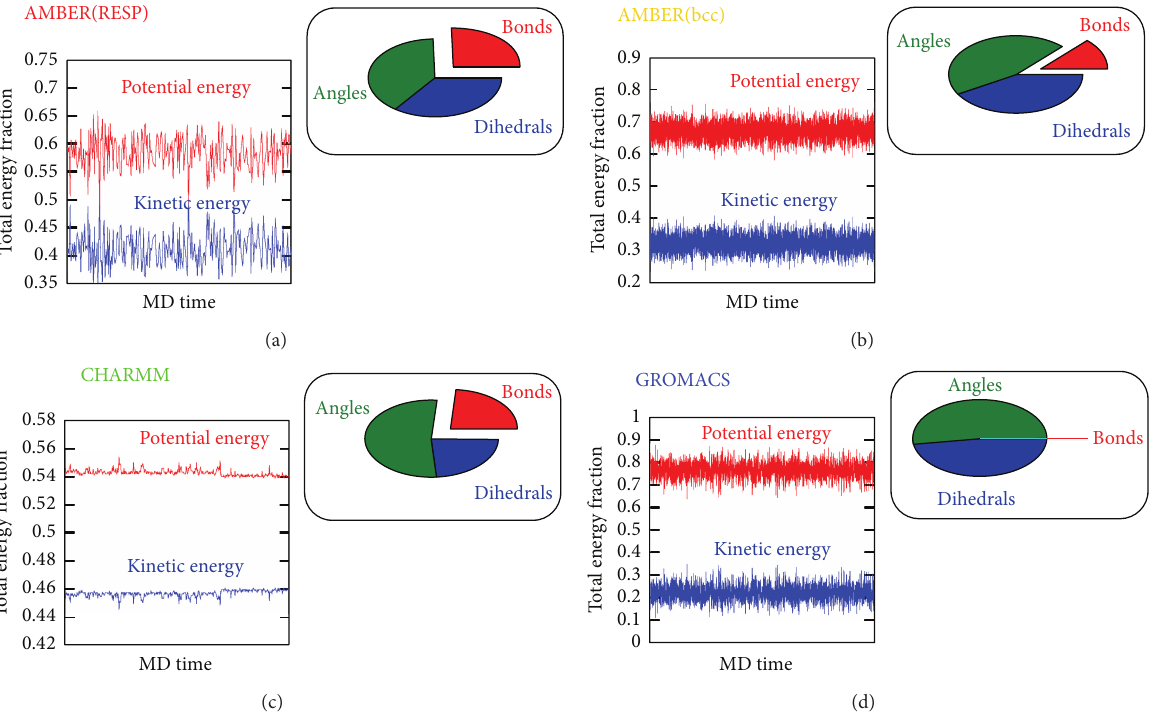
Figure 2: Relative contribution to the total energy from 5ns of MD simulation (gas phase at 300 K) based on force fields: (a) AMBER(RESP), (b) AMBER(bcc), (c) CHARMM, and (d) GROMACS. All panels show the relative contribution of kinetic (blue) versus potential energy (red) to the total energy and the relative fraction of different types of potentials to the nonbonded energy (pie charts examining those degrees of freedom that have been characterized by PCA; see Figure